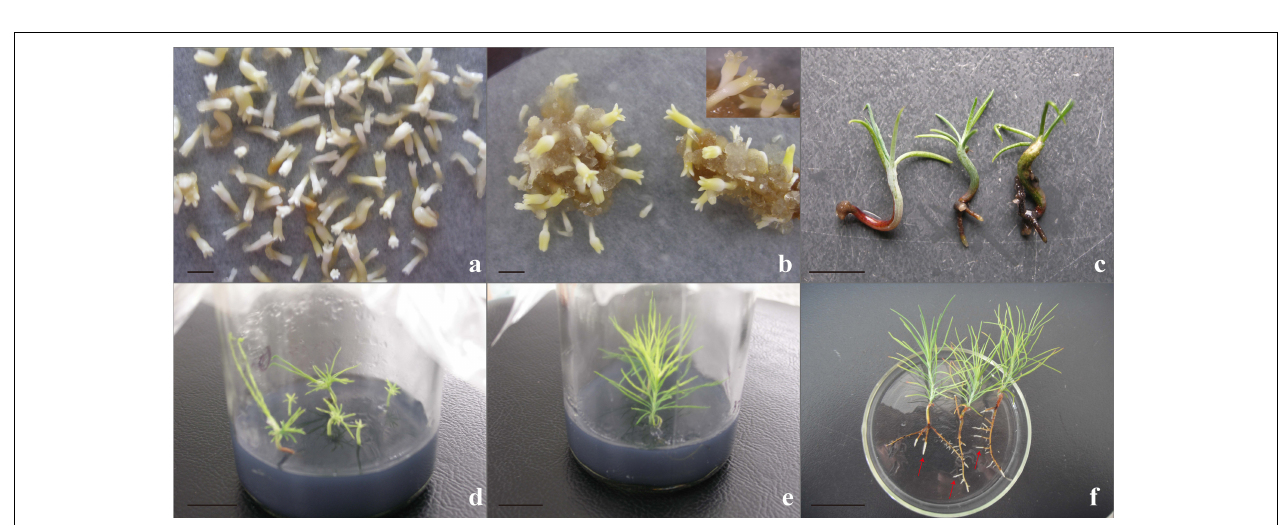
Frontiers in Plant Science |